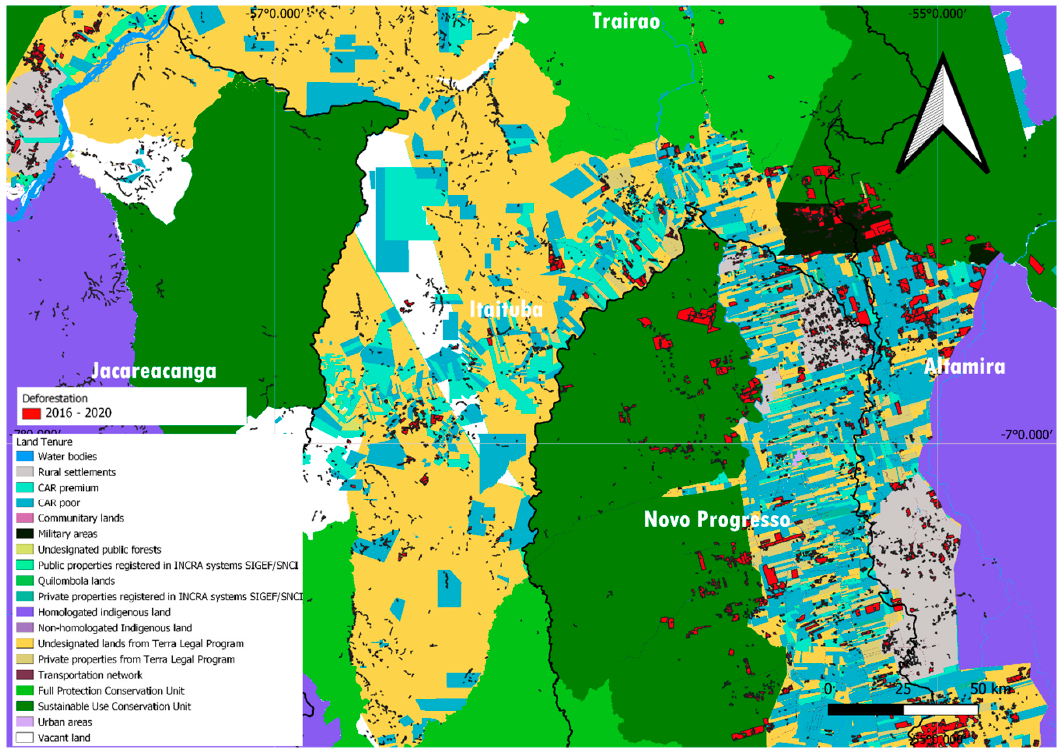
Figure 4. Deforestation in the west of Pará from 2015 to 2020. Source: Elaborated by the authors using data from the INPE 10 and the Atlas Agropecuário from Imaflora 11 .